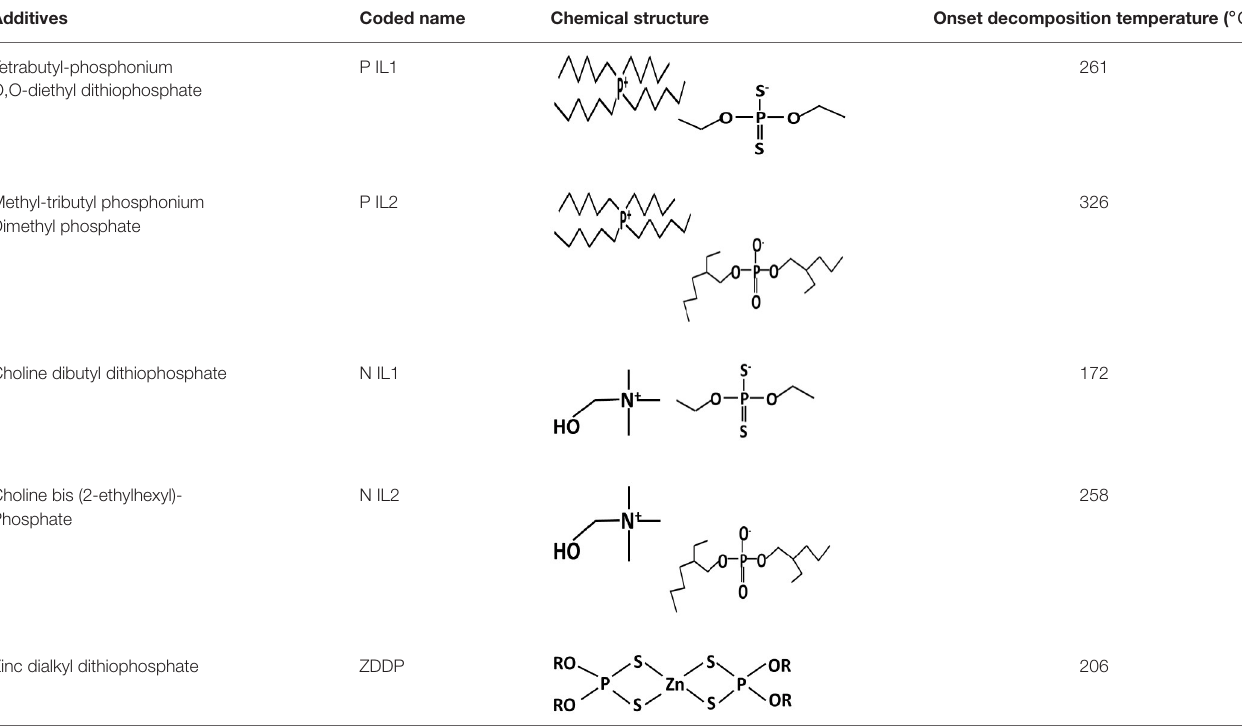
TABLE 1 | Structure of four IL’s and ZDDP and their onset decomposition temperature. Additives Coded